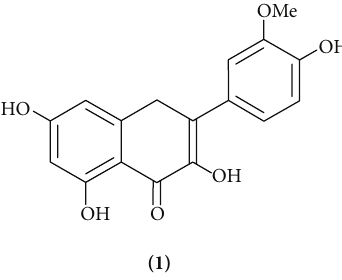
Figure 1: Chemical structure of the flavonoid isorhamnetin ( 1